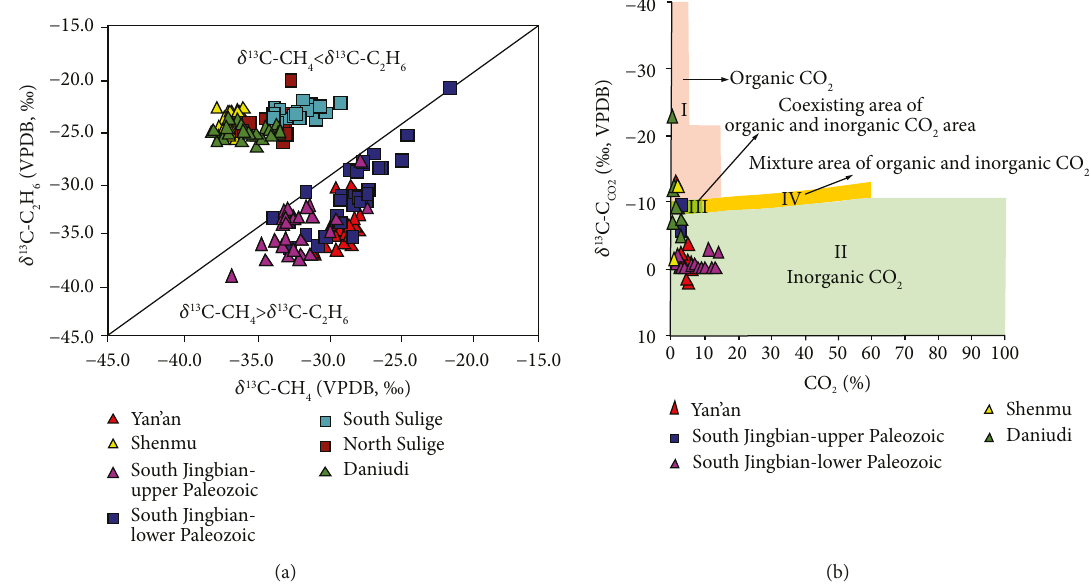
Figure 3: (a) Plot of δ 13 C-C Ordos Basin (modi fi ed from [33]). Note: symbols for samples from di ff erent areas of the Ordos Basin are used in all subsequent fi